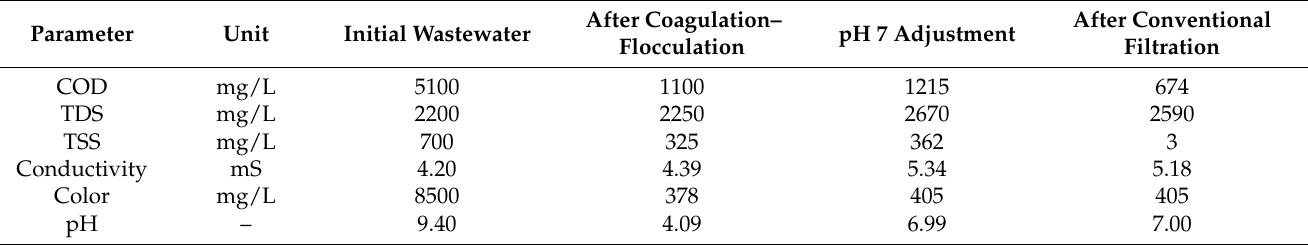
Table 5. Comparison of the batik wastewater